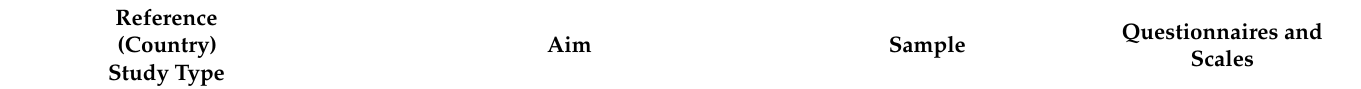
Table 1. Selected studies with their main